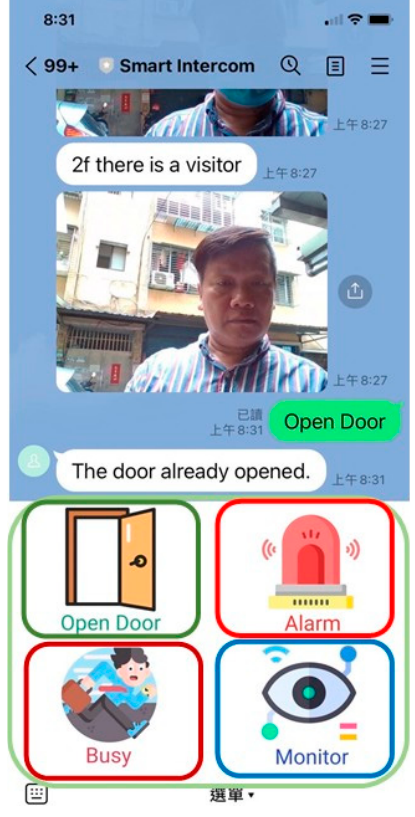
Figure 13. The screenshot of the resident’s smartphone.